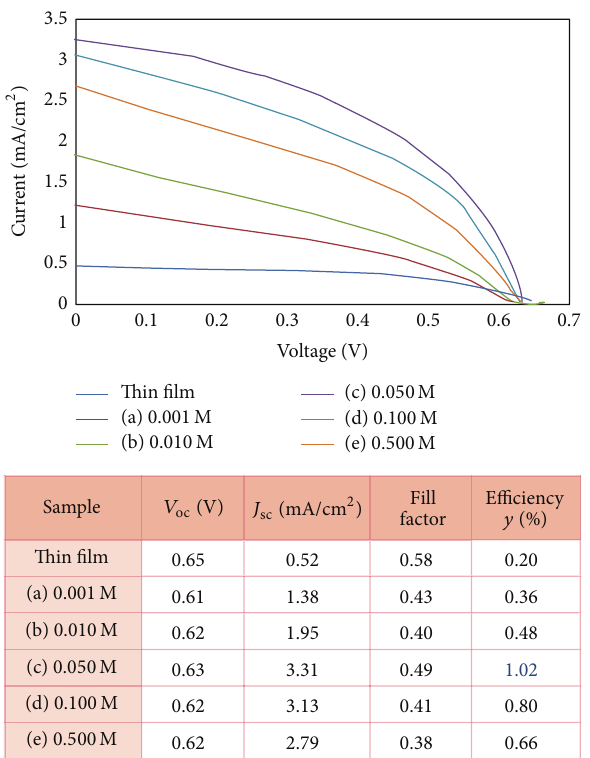
Figure 4: 𝐼 - 𝑉 curve (up) and photovoltaic efficiencies (down) of the TiO 2 seed blocking/In 2 S 3 photosensitizer layered-solar cells.